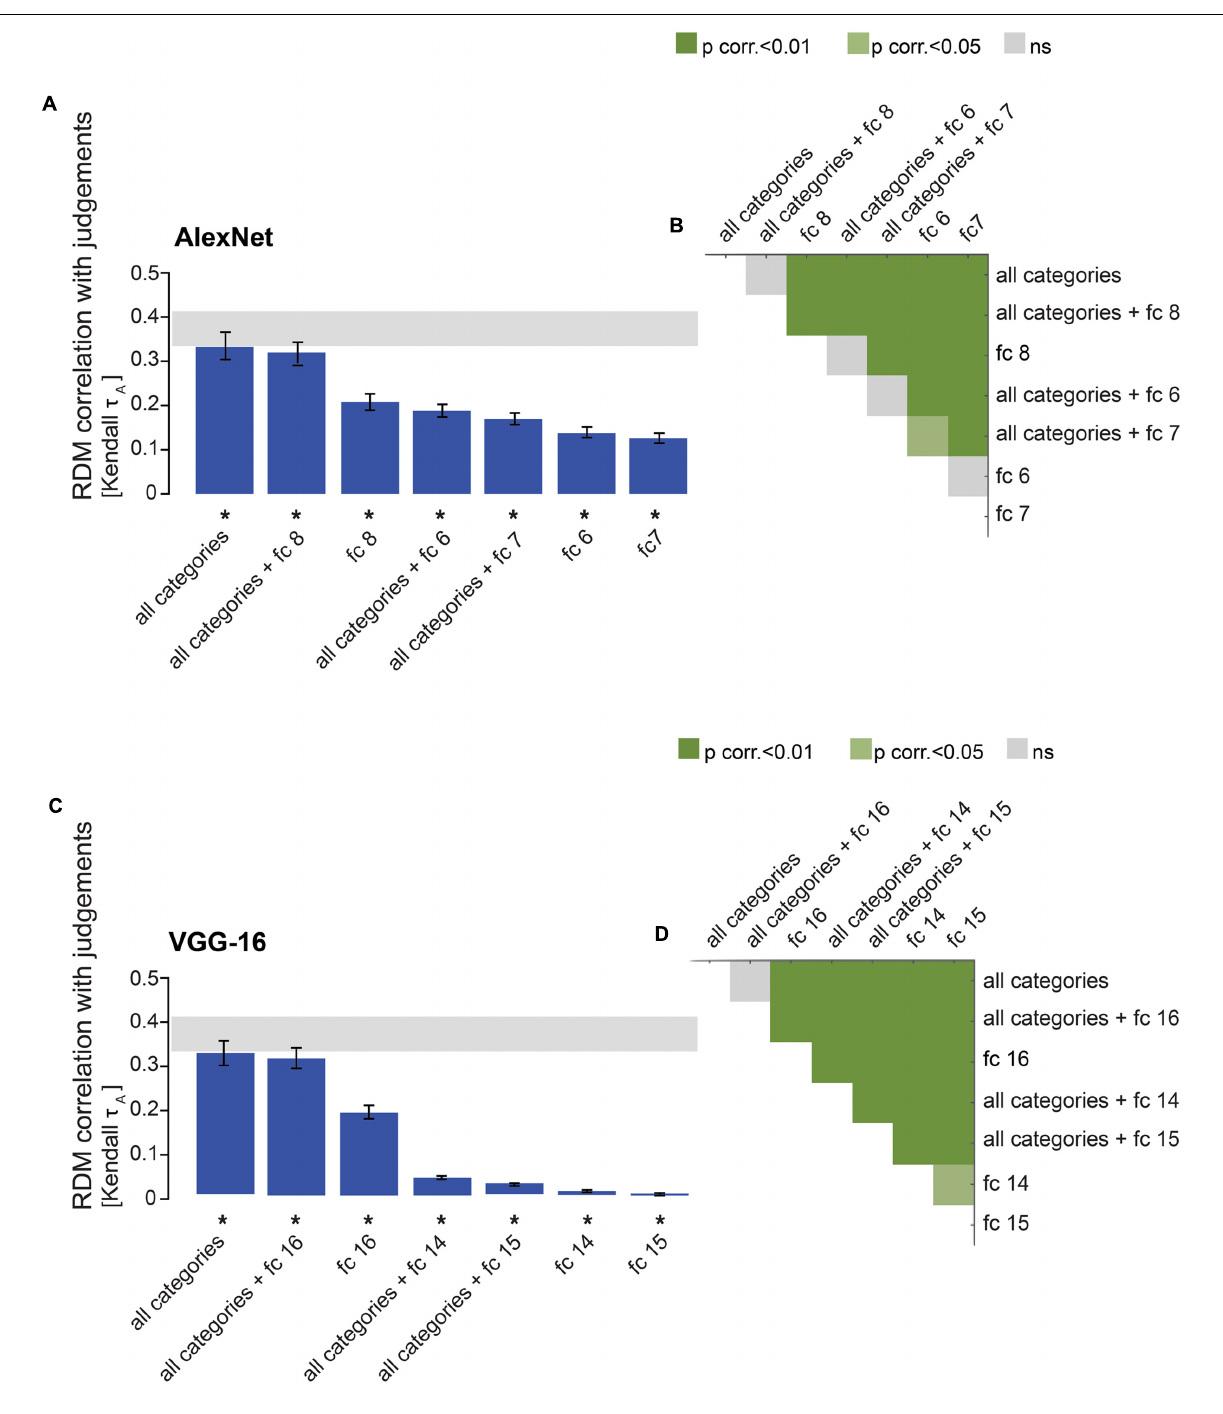
Frontiers in Psychology |